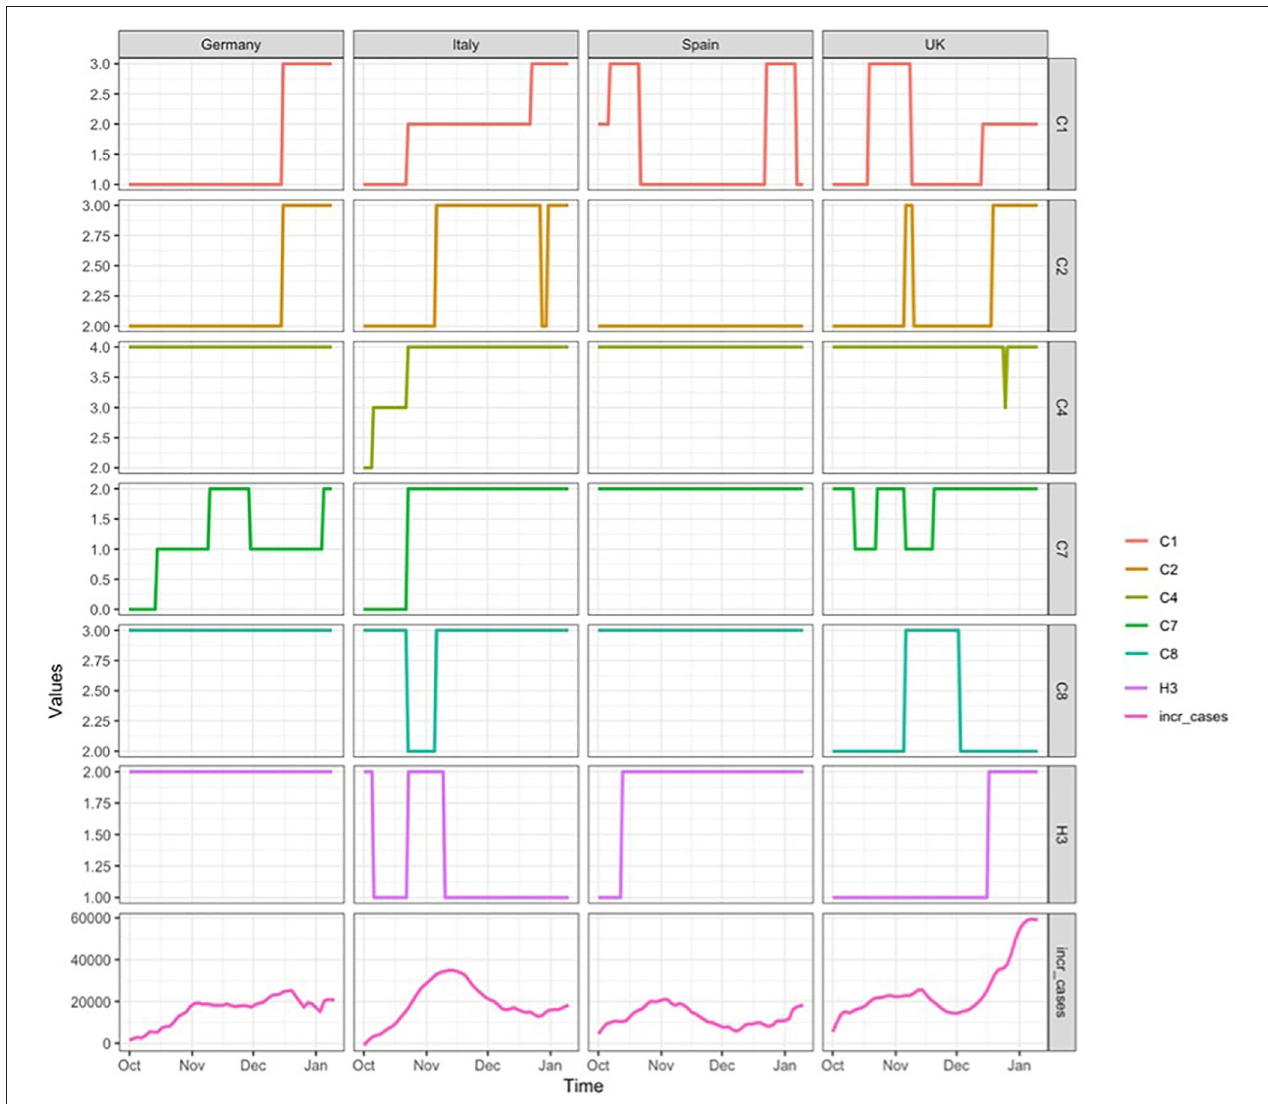
FIGURE 1 | Values’ trend of indicators and trend of incremental confirmed cases across the four European